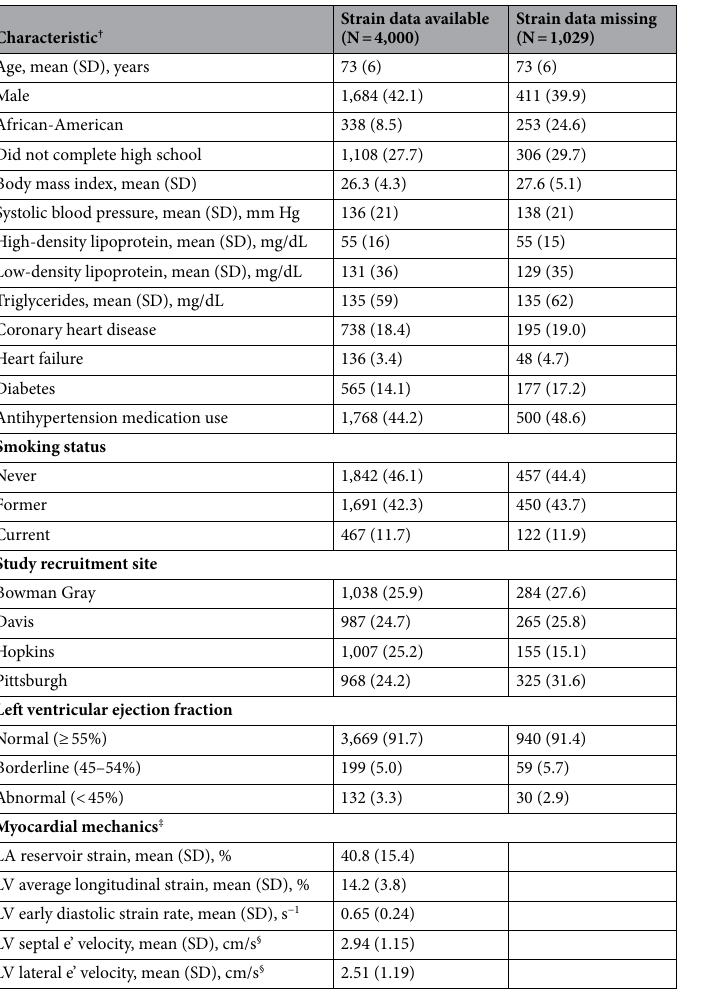
values, with lower absolute values representing worse strain. § Early diastolic (e’) velocities measured